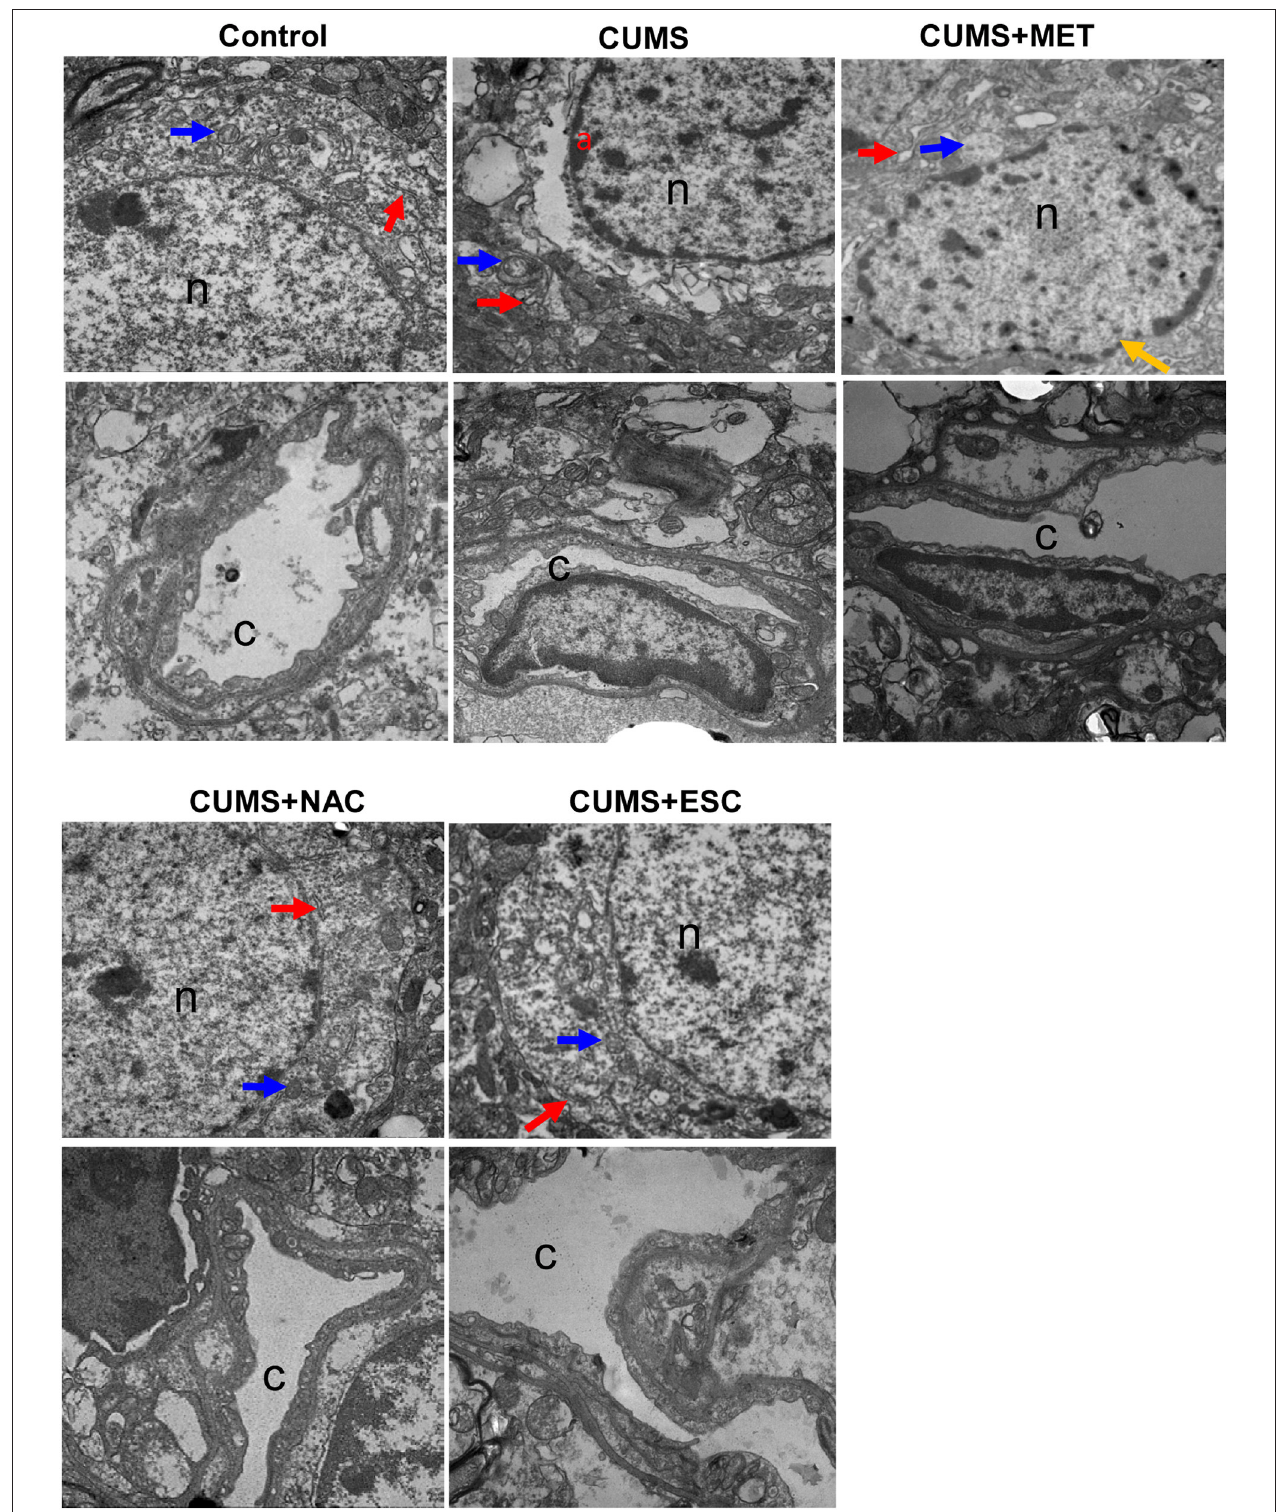
FIGURE 4 | Electron microscope observation of cerebral cortex and hippocampus of rats in each group ( × 2500). “n” represents for the nucleus, “c” represents for the capillaries, “a” represents for chromatin concentration and edge polymerization, the blue arrow represents for mitochondria, the red arrow represents for endoplasmic reticulum, and yellow arrows represents for chromatin